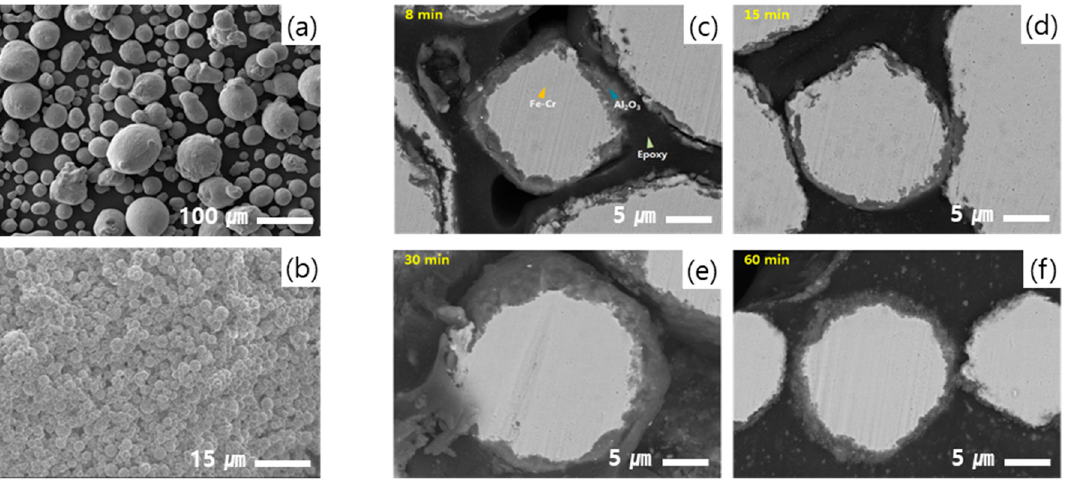
Figure 4. Planar scanning electron microscope (SEM) images of ( a ) Fe-12.5%Cr core powders, ( b ) aluminum oxide shell powders, and ( c – f ) cross-sectional SEM back-scattered images of Fe-12.5%Cr CSSFs with milling time.